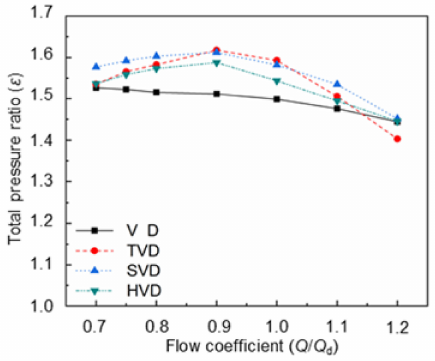
Figure 6. Performance curves for the compressor with different types of